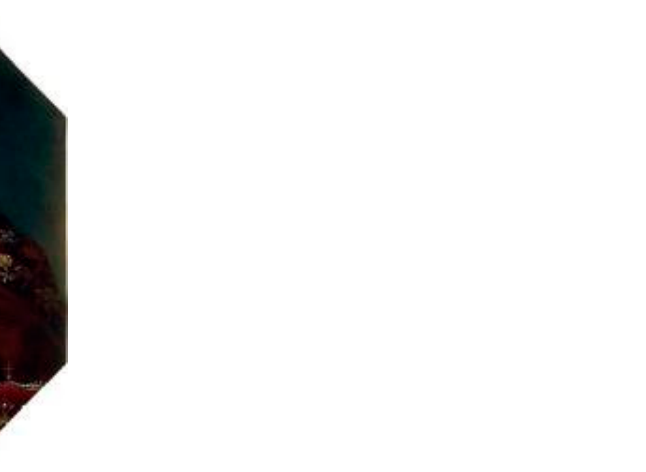
Figure 3. Carlo Dolci, Portrait of St. Kazimierz, 1670–1671. Pushkin State Museum of Fine Arts, Moscow. Image in the Public Domain.